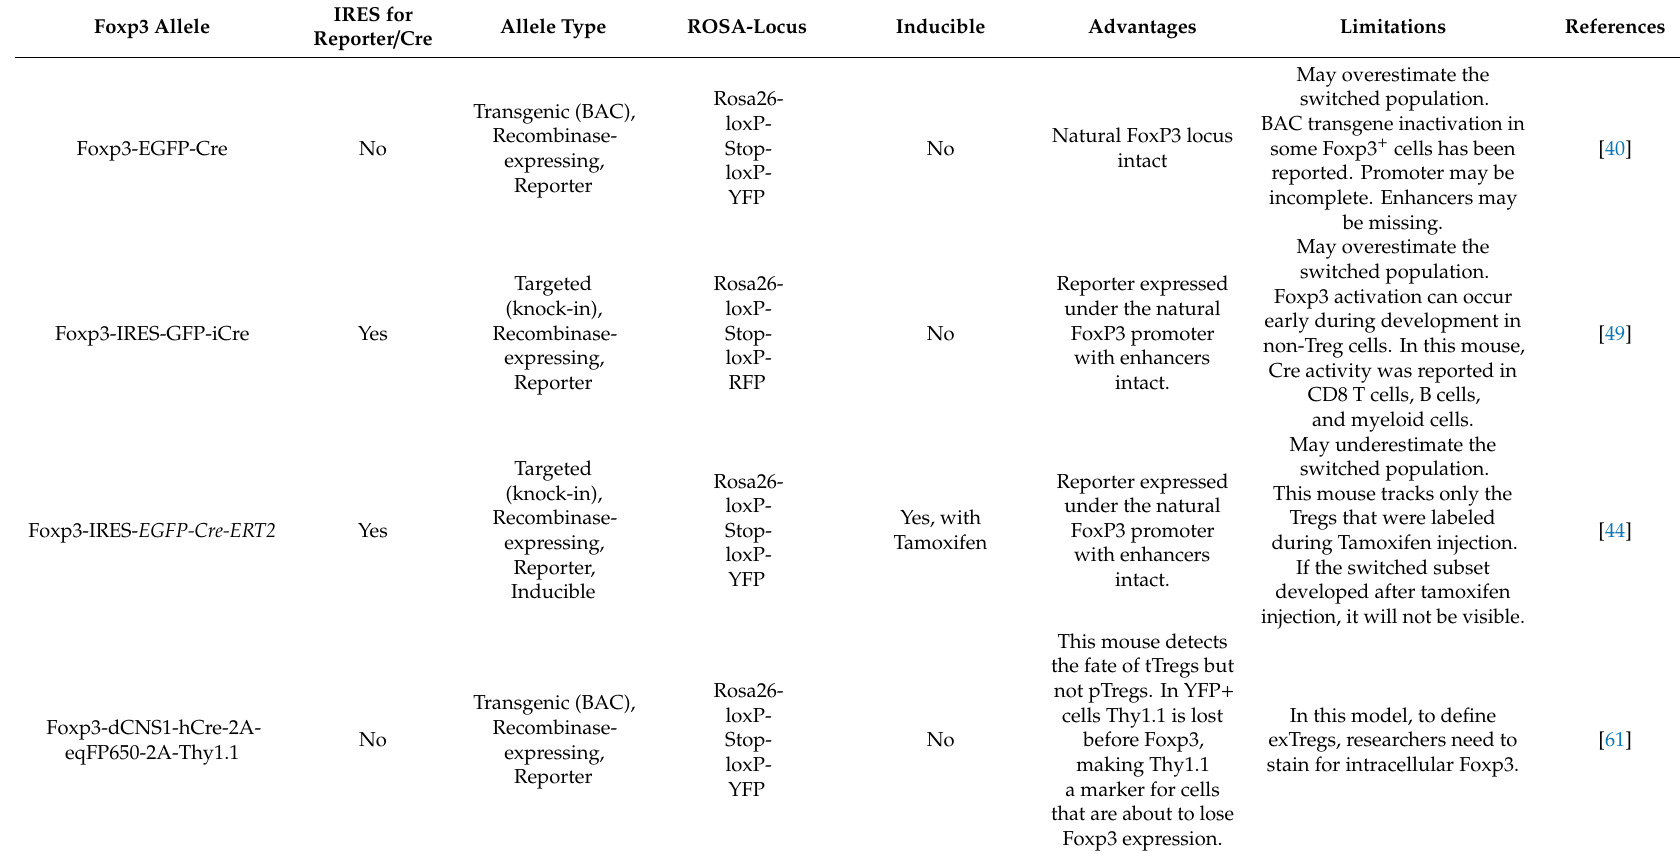
Table 1. Foxp3 lineage tracking mouse